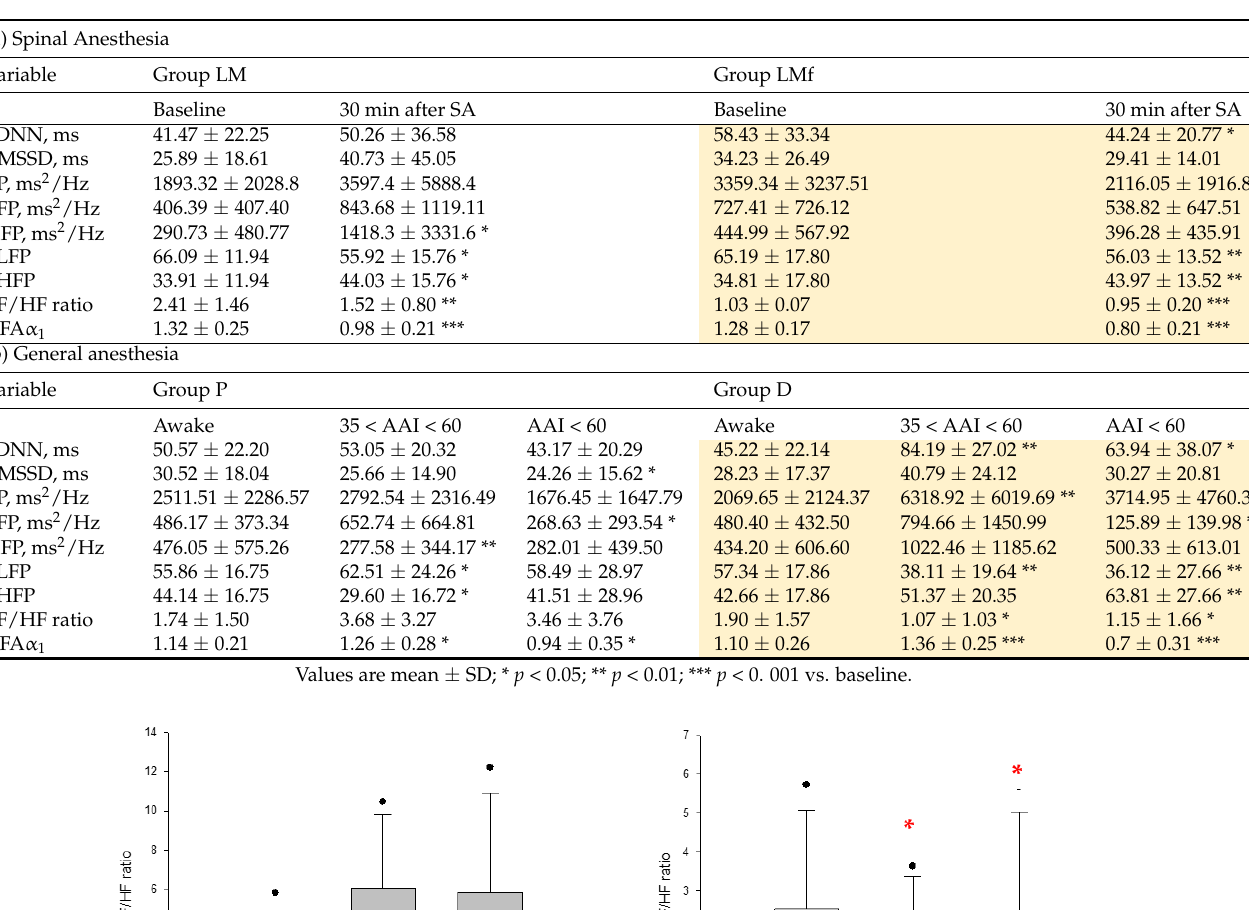
Table 2. Baseline and postanesthesia HRV parameters assessed by spectral analysis and DFA for all groups; (a) spinal anesthesia and (b) general anesthesia.